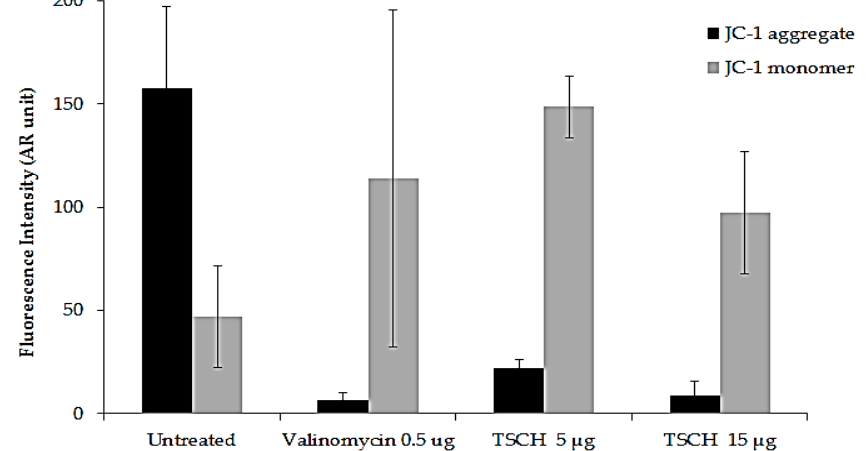
Figure 2. Effect of the water extract of tamarind seed coat (TSCH) on JC-1 fluorescence intensity. HeLa cells were incubated with TSCH at 5 and 15 µg/mL and compared with 0.5 µg/mL valinomycin (chemotherapeutic agent). Fluorescence intensities were analyzed after 30 min of JC-1 incubation. Values represent the mean ± S.D. of 10,000 cells.